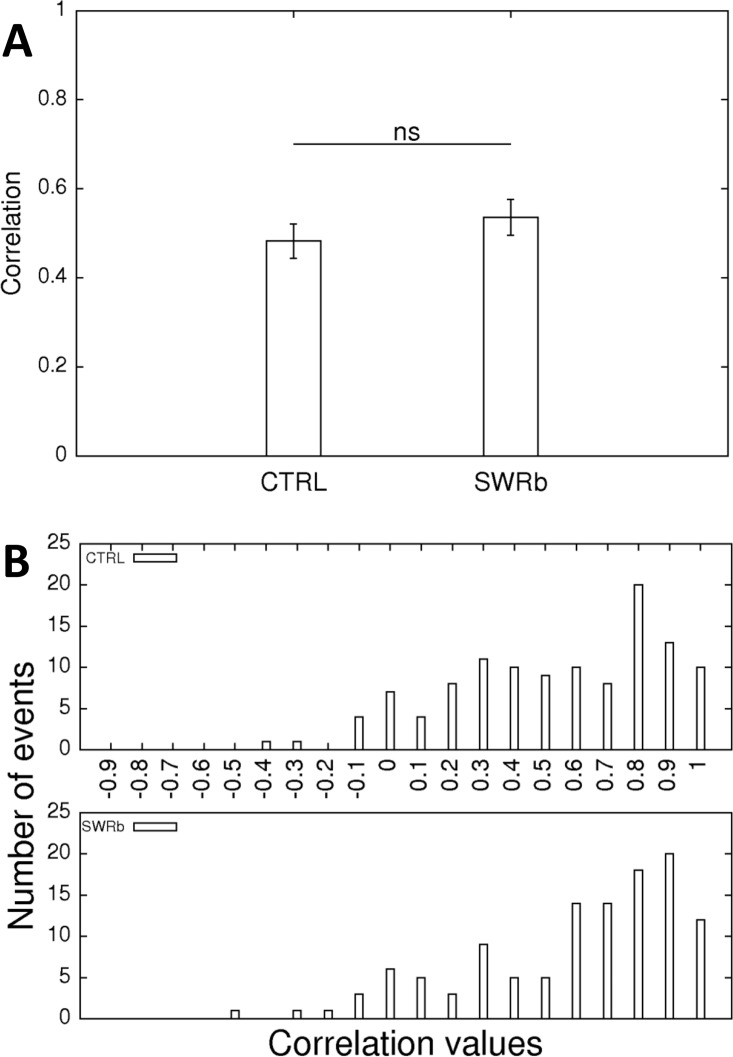
Stability of the firing rate maps.(A) Pearson correlation of the firing rate maps between the first and second exploration of the same environment on control days (left bar) and SWR-blockade days (right bar). No significant difference is detected (p = 0.334; Oneway ANOVA). (B) The distribution of such changes is shown as a histogram using bins of 0.1 along all possible correlation values. The two distributions are not significantly different (Kolmogorov-Smirnov test; p = 0.983; D = 0.10).